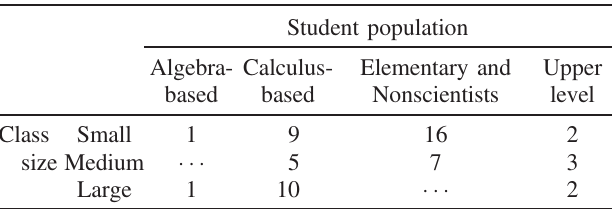
TABLE III. Number of courses for each combination of student population and class size, “ (cid:2) (cid:2) (cid:2) ” indicates no courses have a given combination. Student population Algebra- Calculus- Elementary and Upper based based Nonscientists